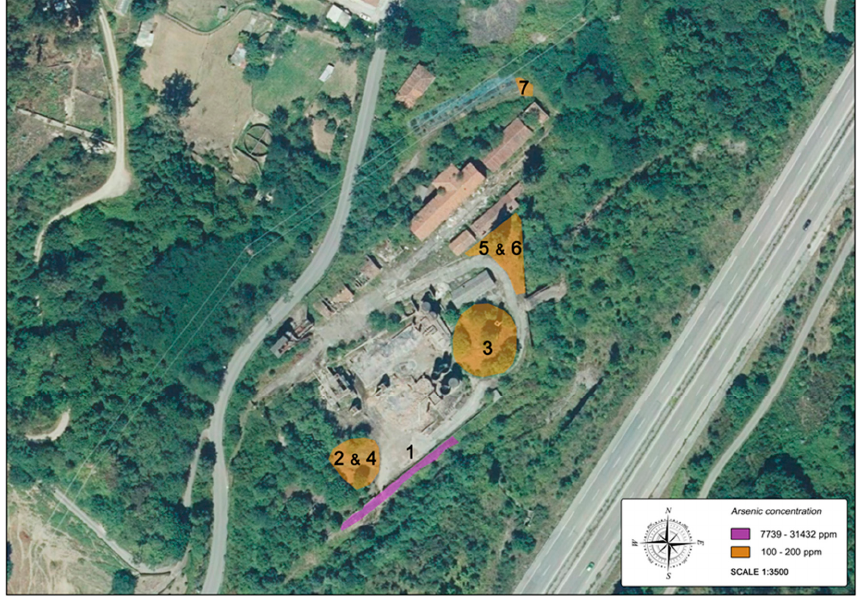
Figure 2. Distribution of sampling areas in which the highest values of CoI were found: 1 ( Calluna vulgaris ), 2 ( Betula celtiberica ), 3 ( Salix atrocinerea ), 4 ( Dactylis glomerata ), 5 ( Agrostis tenuis ), 6 ( Plantago lanceolata ) and 7 ( Trifolium repens ). Table 4. Average content of metal(loid)s in soil and plant samples for the seven selected species analyzed (n = 3, uncer- tainties below 10% for all determinations). Data for elements with soil contents below 100 mg·kg − 1 (= ppm) are not indicated and were not considered for the calculation of accumulation factors (see Table 5).